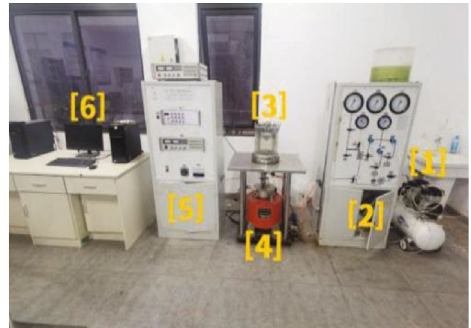
Figure 2: DSZ-2 schematic con fi guration of the experiment.